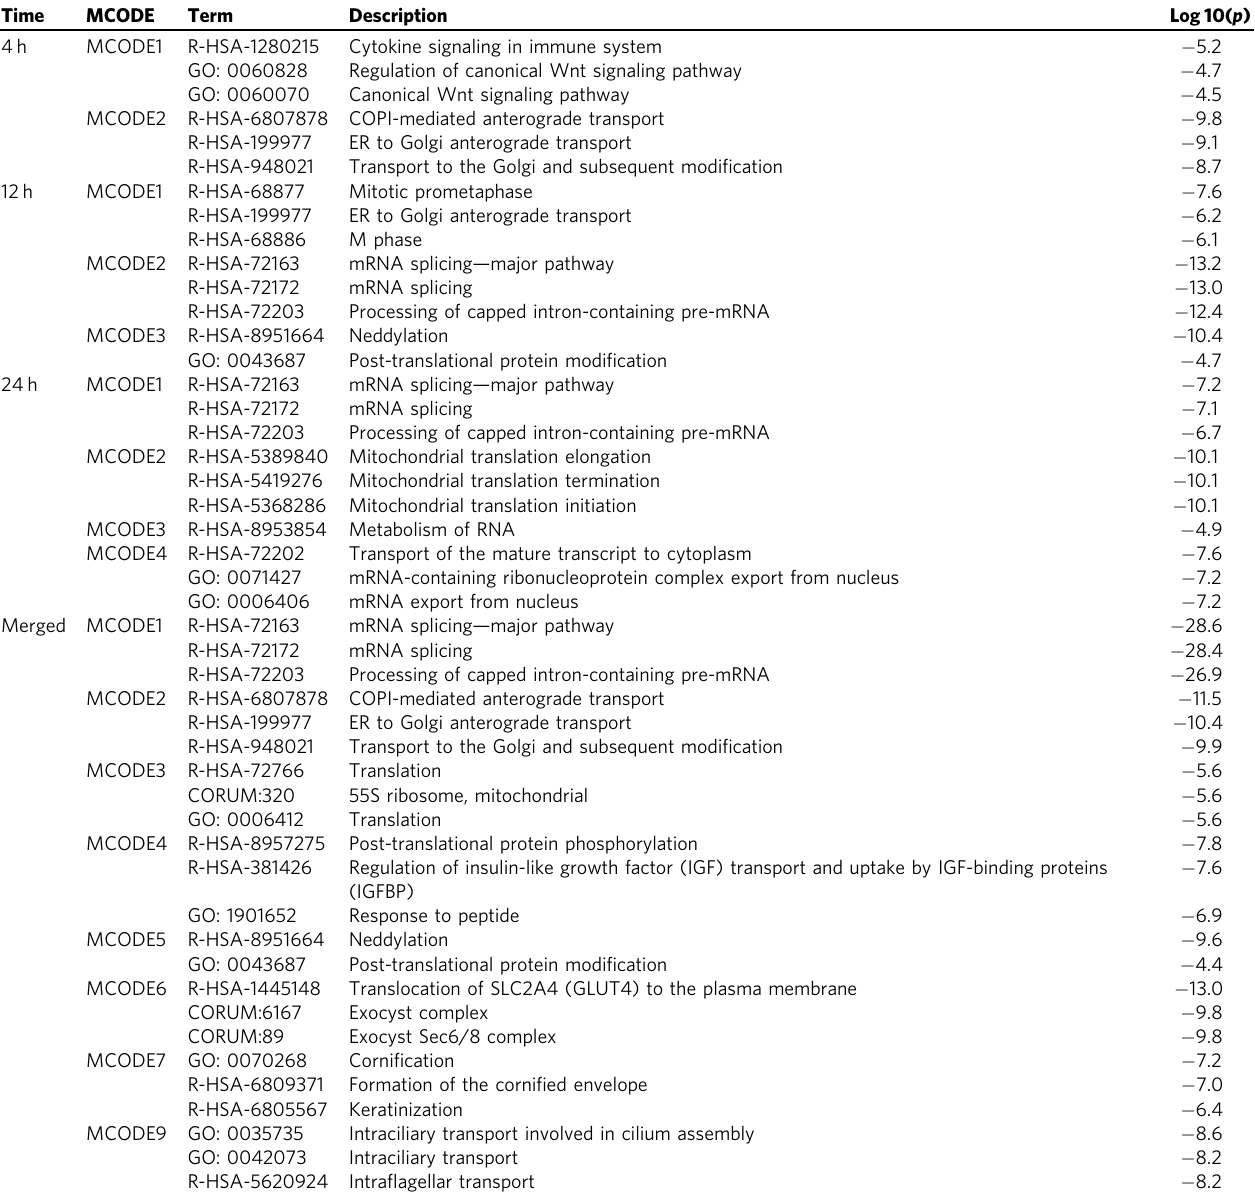
Table 1 Protein – protein interaction MCODE